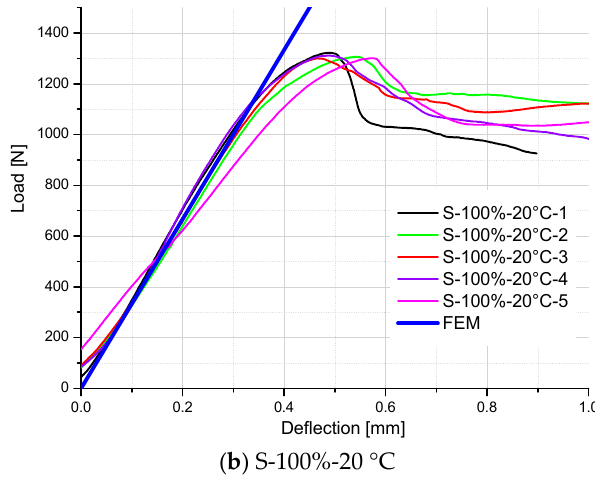
Figure 10. Comparison of load–deflection curves between FE analysis and test results of S-0%-20 °C specimens and S-100%-20 °C specimens.